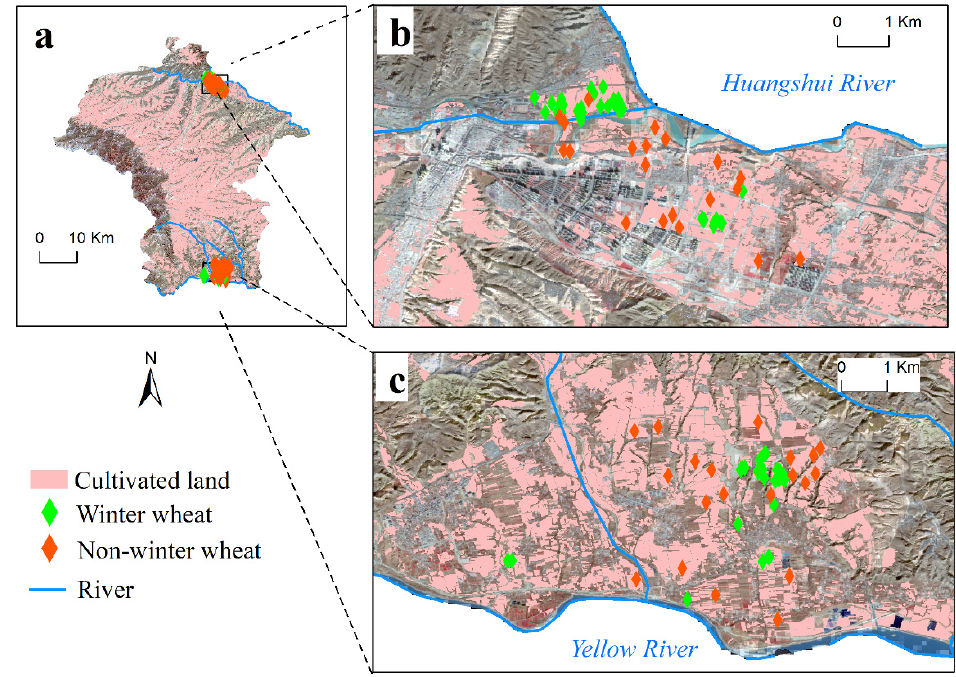
Figure 5. Distribution of sample points. ( a ). Location of sample boxes in Minhe; ( b , c ). Distribution of winter wheat and non-winter wheat sample points in the sample boxes.